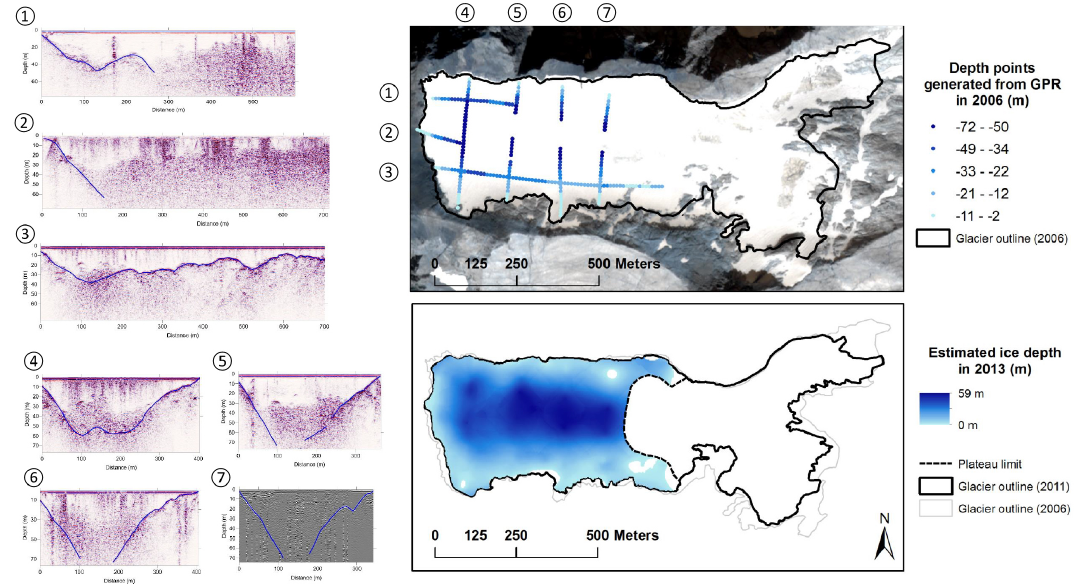
Figure 12. Map: bedrock depth as interpreted from GPR radargrams superposed on a 2013 XS Pléiades image. Numbers 1 to 3: interpretations of longitudinal radargram acquisitions. Numbers 4 to 7: interpretations of transverse radargram acquisitions.